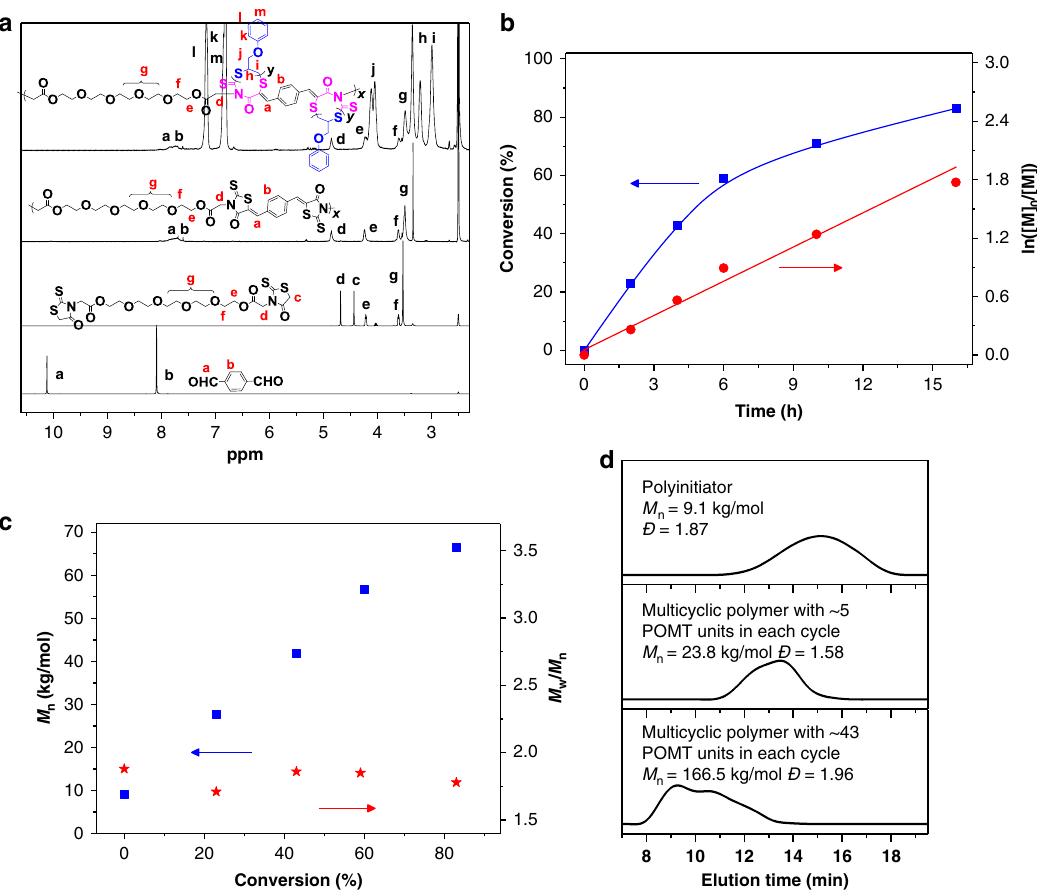
Fig. 6 Synthesis of linear multicyclic polymer with cyclic structures in the backbone. a 1 H NMR spectra of resulting polyrhodanine initiator and multicyclic polymers. b Monomer conversion and ln([M] 0 /[M]) versus polymerization time during the synthesis of multicyclic polymer. c M n and Ð of multicyclic polymers at different time. d SEC curves of resulting polyrhodanine initiator and multicyclic